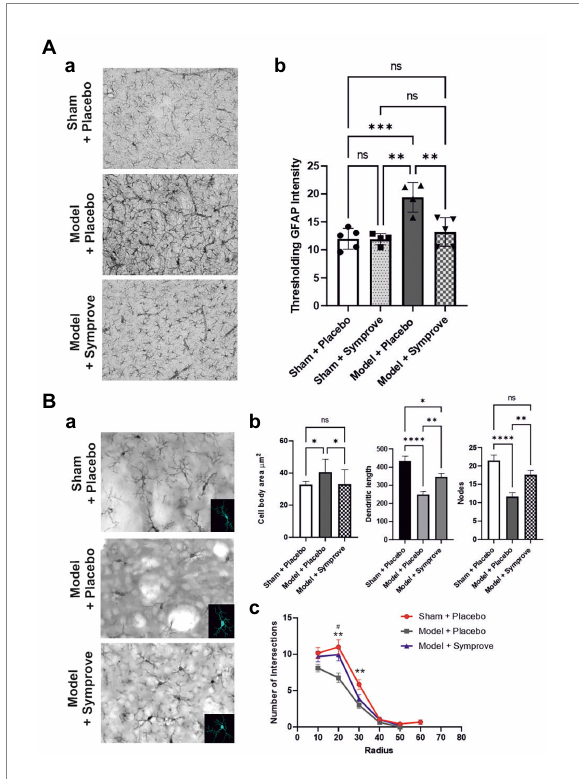
FIGURE 10 Effect of Symprove ™ on striatal neuroinflammation. (Aa) Representative immunohistochemical staining of GFAP in the striatum of a sham (top panel) and a PD model animal (middle panel) treated with placebo and a PD model animal treated with Symprove ™ (bottom panel). (Ab) Thresholding analysis of GFAP staining revealed an increase in the GFAP staining in the